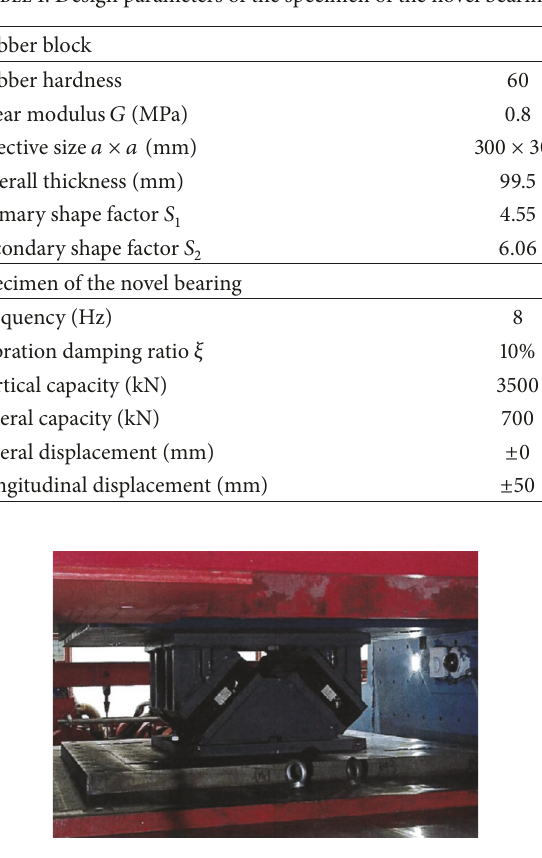
and 𝐾 𝑉1 can be obtained based on 𝑑 1 , 𝑑 2 = 𝑃 0 /𝐾 𝑉1 , . . . ,